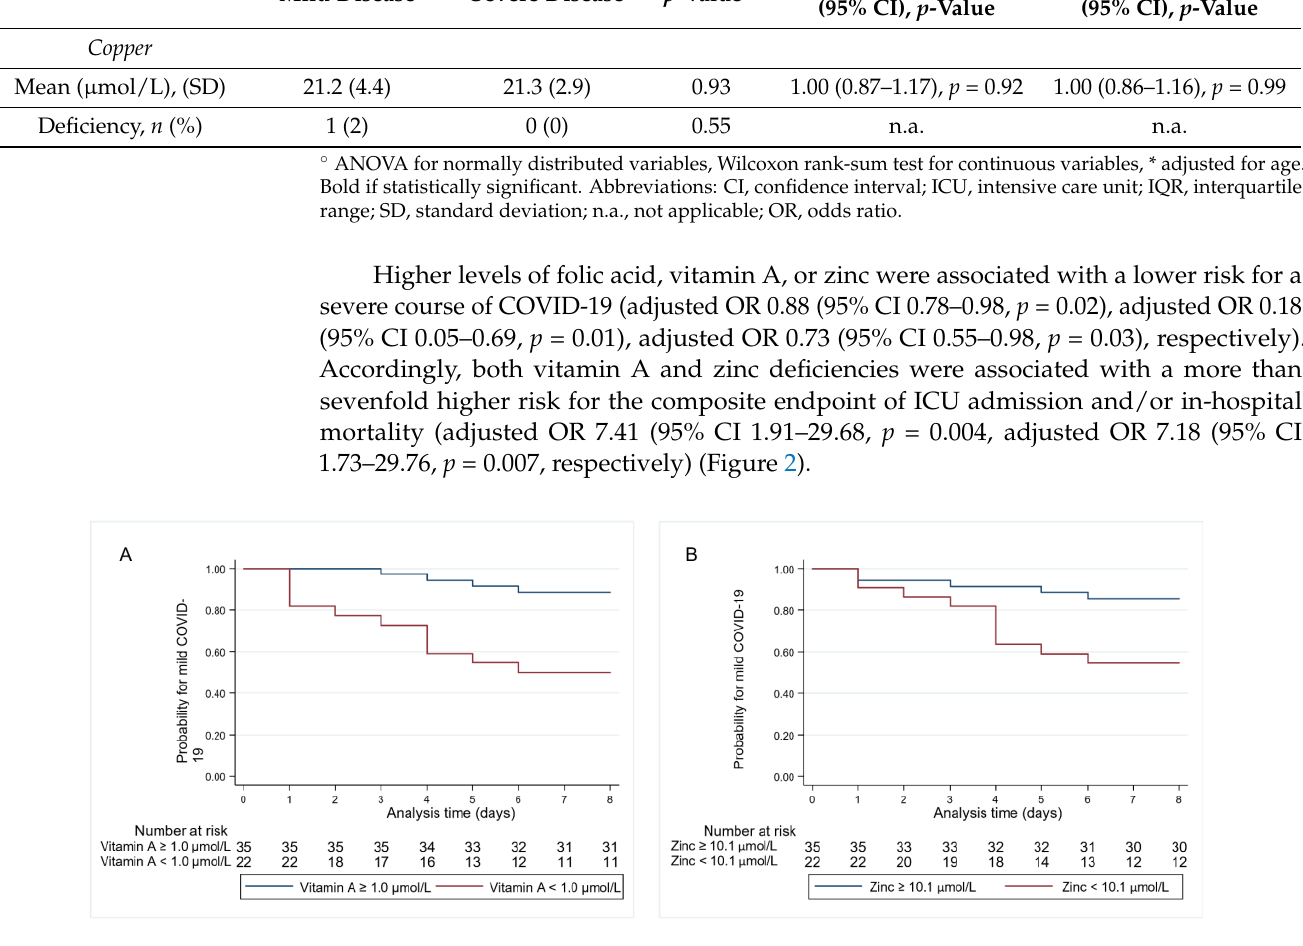
Figure 2. Kaplan–Meier estimates for time to composite endpoint stratified by ( A ) vitamin A defi- Figure 2. Kaplan – Meier estimates for time to composite endpoint stratified by ciency and ( B ) zinc ( A ) vitamin A deficiency and ( B ) zinc deficiency.